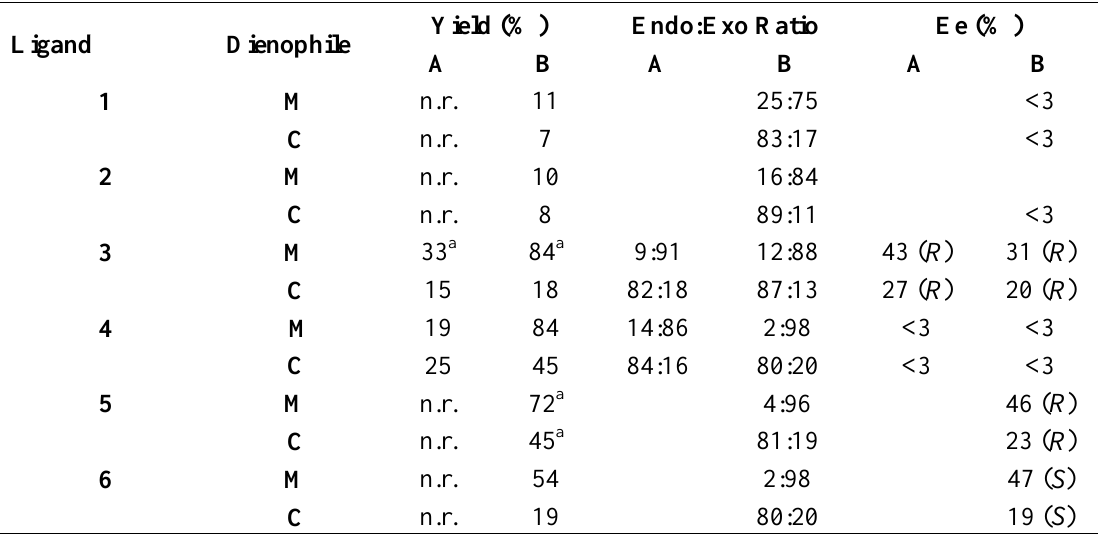
Table 2. Results of the Diels-Alder reaction using tantalum(V) chloride.